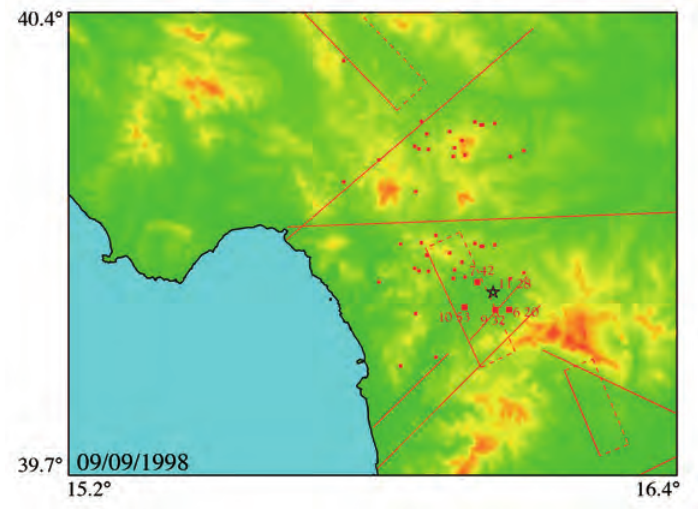
Fig. 7. Events observed on 9th September 1998. The star refers (in the following figures too) to the main event (at 11.28 UTC), larger squares to the foreshocks (with relative UTC timing), smaller squares refer to aftershocks locations.